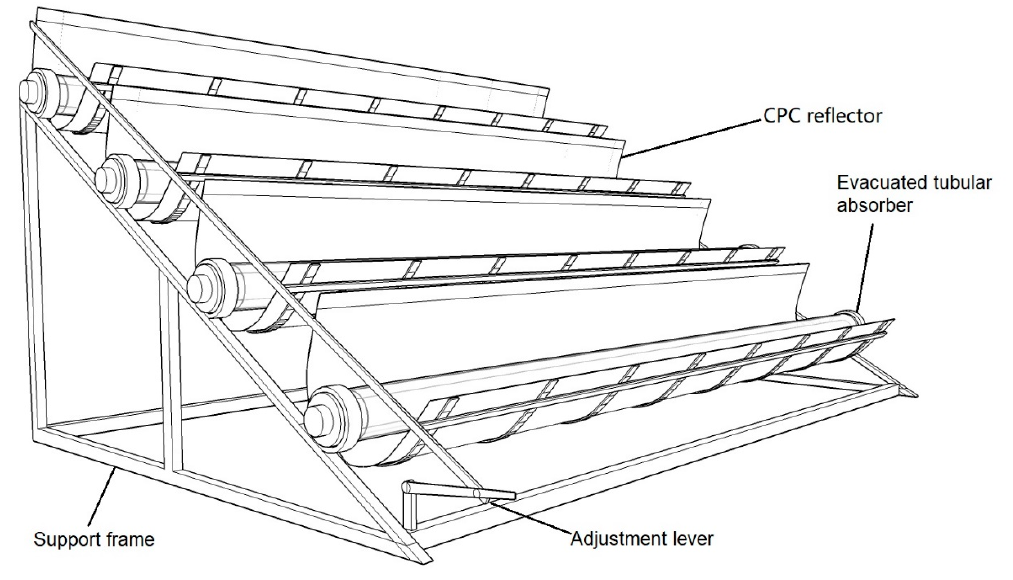
Figure 25. Schematic view of the east–west axis TCPC.